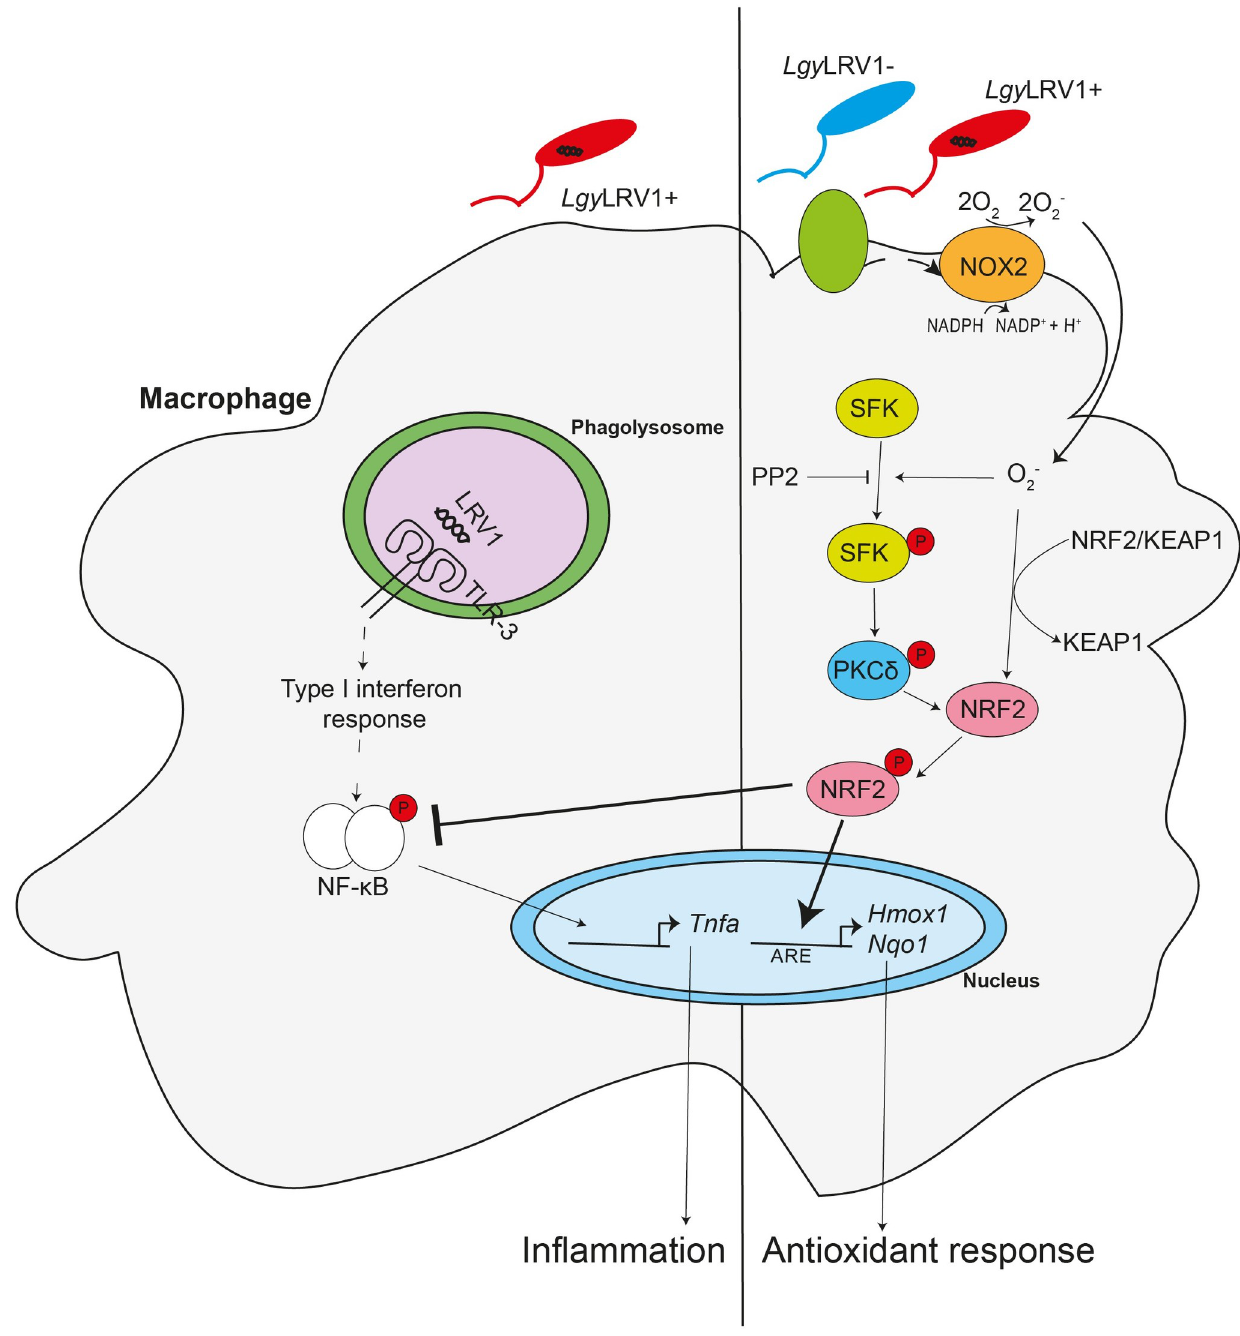
Fig 8. NRF2 protects from oxidative stress and hyperinflammation in Lgy infection. During infection with Lgy parasites, the NRF2 pathway is activated independently of LRV1 by the production of oxidative species by NOX2. NOX2 activation triggers PKC δ phosphorylation by SFK resulting in the release of NRF2 from its negative regulator KEAP1. Stabilized NRF2 translocates to the nucleus favoring the antioxidant response. Concomitantly, stabilized NRF2 blocks the induced pro-inflammatory response activated by LRV1. Thus, NRF2 activation results in activation of the antioxidant response and restriction of the pro-inflammatory response in Lgy